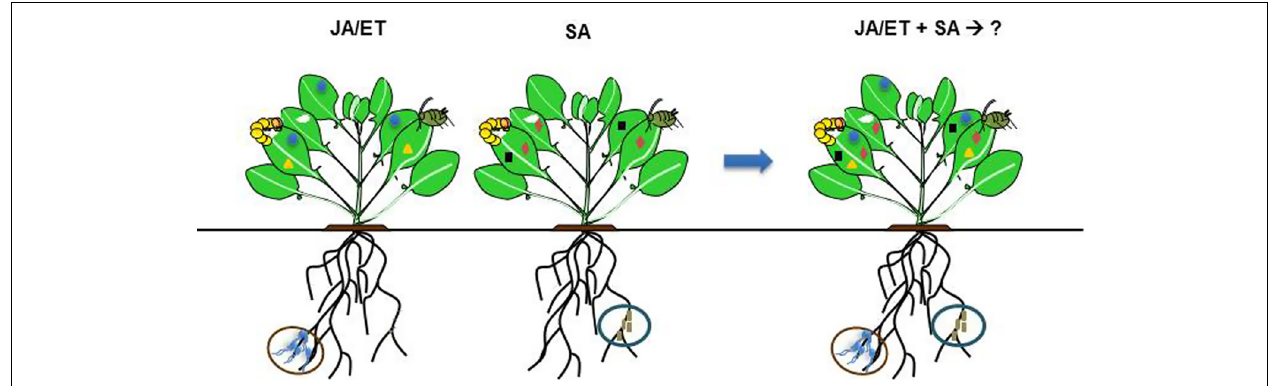
multiple root-associated microbes that mediate ISR via different signaling pathways may activate higher diversity of defense-associated genes that can enhance plant defense against insects or pathogens. Crosstalk between multiple signaling pathways (JA/ET–SA) regulating ISR within the plant and on how it will affect the outcome of interactions is not known. Different shape of symbols in the leaves represent different defense- associated